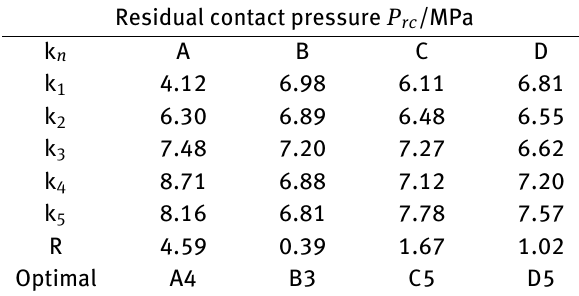
Table 2: Factors and levels of orthogonal experiment A